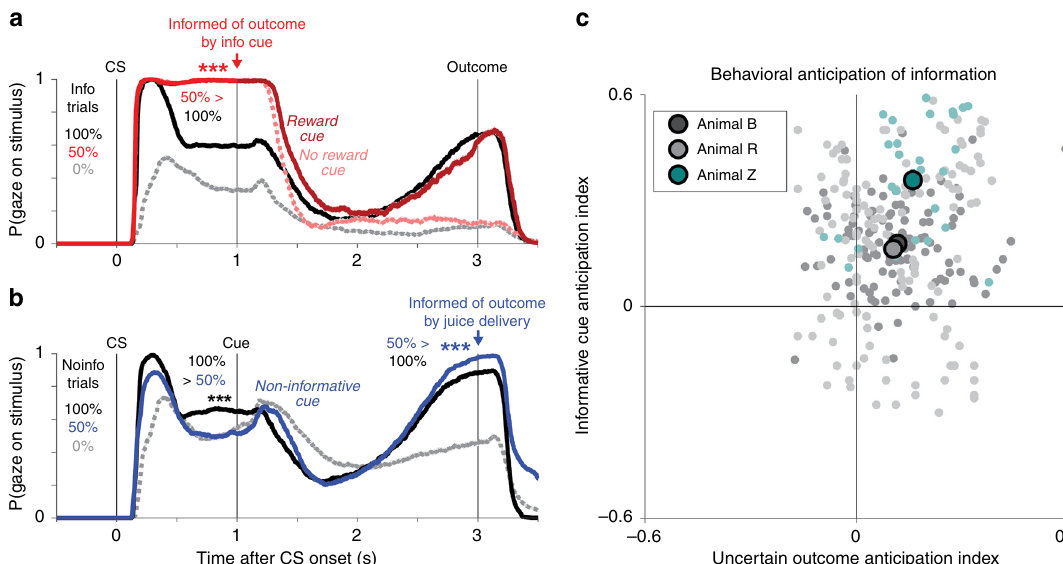
Fig. 4 Monkeys anticipate the moment of gaining information by gazing at objects associated with the uncertain outcome. a Monkeys ’ gaze on Info trials is attracted to CSs in anticipation of receiving informative cues about uncertain rewards. Lines indicate the probability at each millisecond that the animal gazes at the stimulus. Shaded areas indicate ± 1 SE (most too small to see). Monkeys gazed more at the 100% CS (black) than the 0% CS (gray), but gazed most of all at the uncertain 50% CS (red) which could be followed by informative cues indicating either reward (dark red) or no reward (pink). Gaze at reward cues then ramped up to the time of reward delivery, while gaze at no-reward cues was minimal. The data are from all n = 68 sessions of the version of the information task with the displayed task timing parameters. *** indicates p < 0.001 (signed-rank test) of the difference indicated by the text at the moment of a task event. b Gaze on Noinfo trials is attracted to objects in anticipation of outcome delivery. Same format as ( a ). During the CS period, monkeys had roughly value-based gaze behavior (100%> 50% > 0%), but during the cue period their gaze on 50% reward trials ramped up in anticipation of the uncertain outcome until it became greater than all other conditions (50% > 100% > 0%). c Uncertainty-related gaze behavior in each animal signi fi cantly anticipated informative cues ( y -axis) and uncertain outcomes ( x -axis). The data are from n = 112, 151, 29 sessions from animals A, R, Z. Same format as Fig. 3d, but analyzing gaze instead of neural activity. Colors indicate animals; light dots are single sessions; dark circles are means in each animal, error bars are ± 1 SE (most too small to (Fig. 4a, b, 100% CS > 0% CS, informative reward cue > no- reward cue).